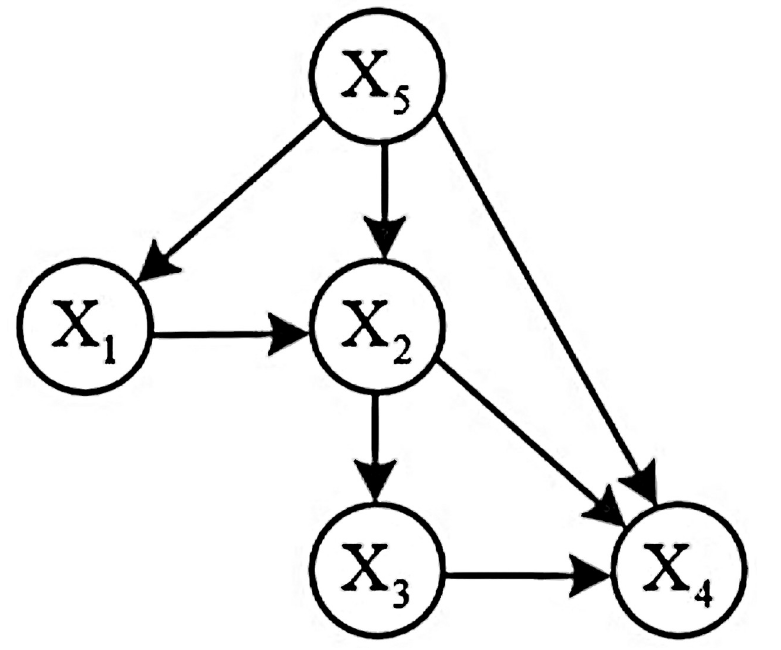
Fig 2. Overall process